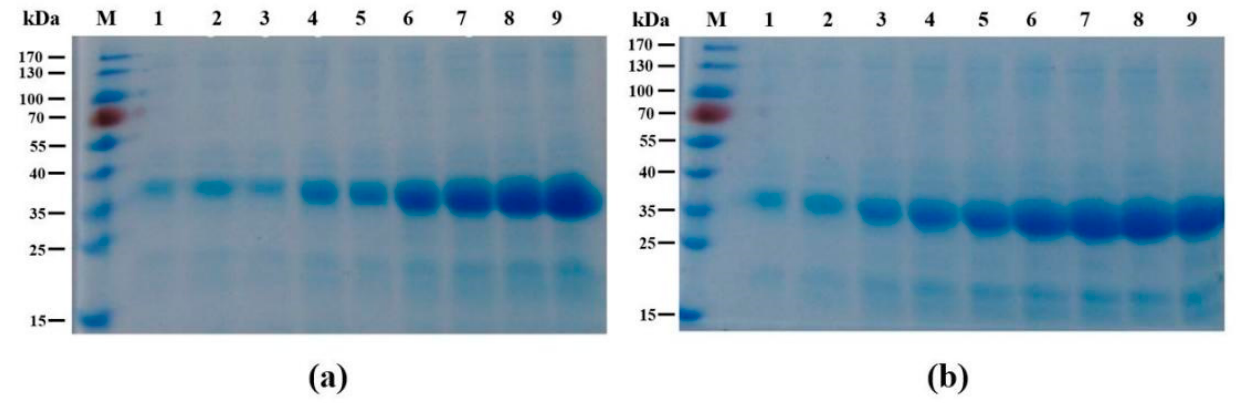
Figure 5. SDS-PAGE analysis ofsupernatant obtained during culture in a 10 L fermenter; raw glycerol fed-batch fermentations in a 10 L fermenter with a 4 L initial modified FM22 medium. Lane M, protein molecular weight marker (Fermentas, Burlington, Canada); lanes 1–9, 15 µ L of culture supernatant at 27.3 h, 37.6 h, 45.1 h, 51.2 h, 61.9 h, 68.8 h, 75.0 h, 85.9 h, and 94.6 h, respectively.